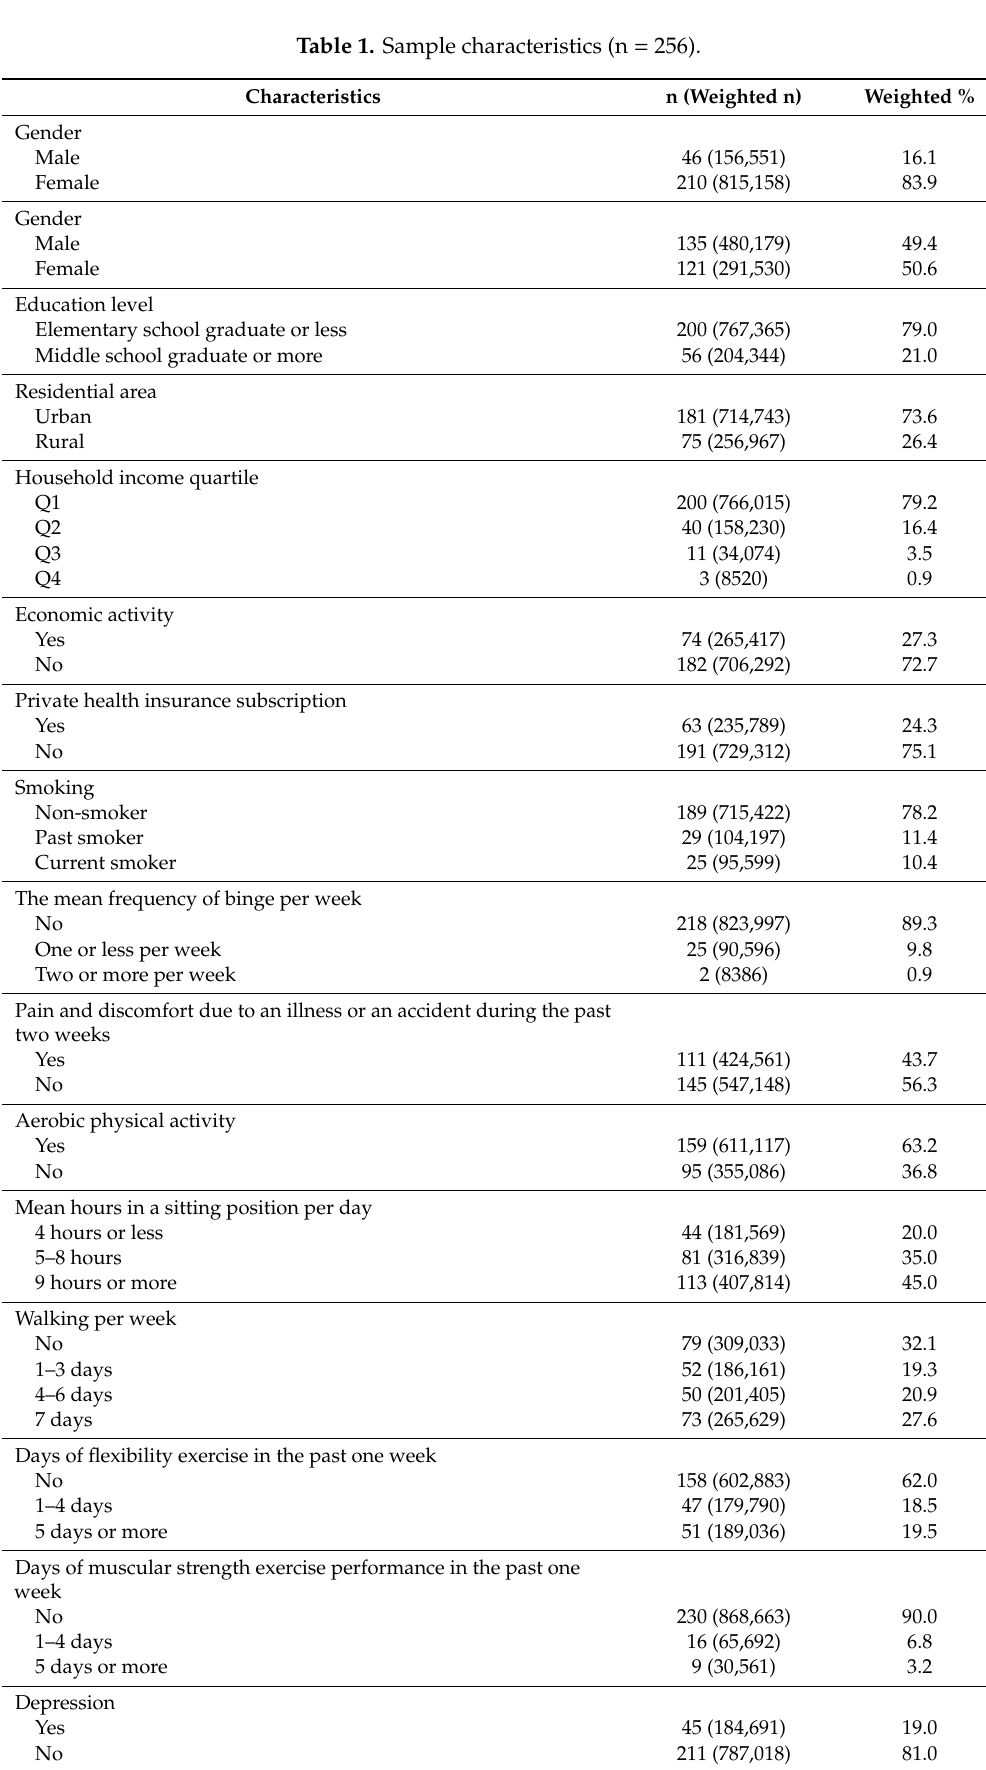
Table 1. Sample characteristics (n =